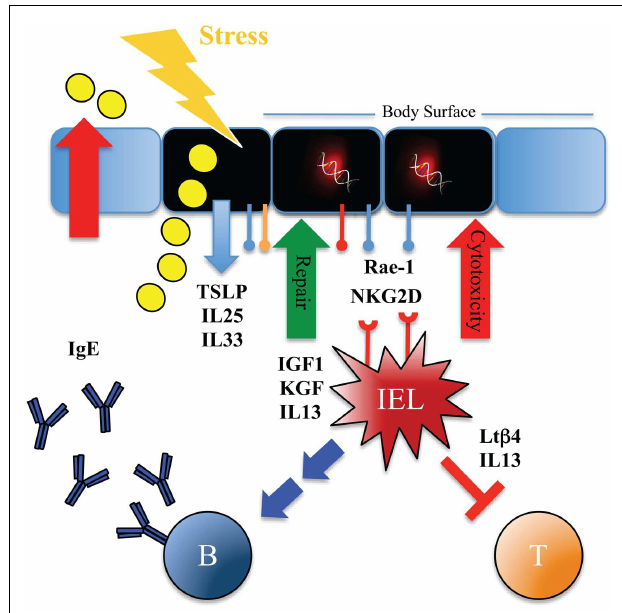
FIGURE 2 | Immune surveillance with type 2 immunity promotes tissue homeostasis and protects against carcinogenesis using numerous layers of control . Scheme illustrating possible mechanisms whereby tissue-resident IELs can provide rapid host-protective immune surveillance and re-establish tissue homeostasis at body surfaces.Tissue stress as imposed by mechanical disruption, injury, or exposure to noxious environmental substances such as chemicals, carcinogens, UV-irradiation or toxins prompts ECs to release IL-25, IL-33, andTSLP cytokines, and upregulate expression of stress-ligands such as Rae-1, CAR, and plexins. This activates the resident IELs and their responses include